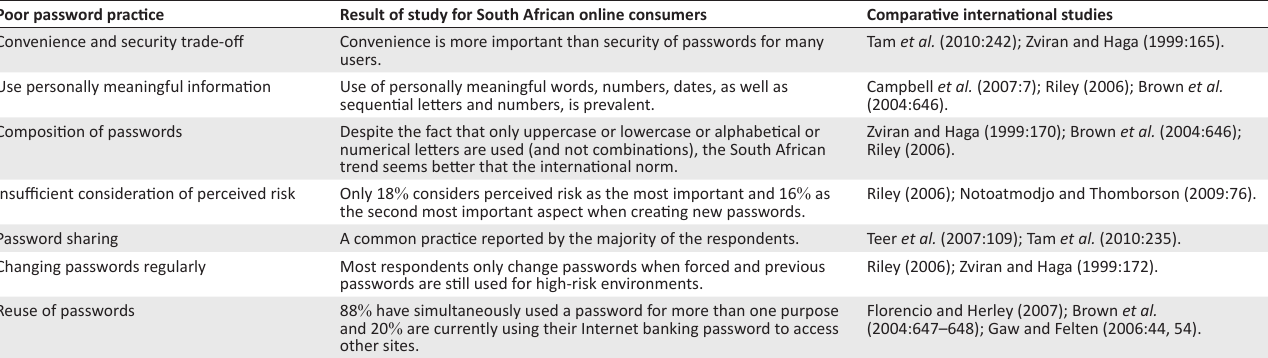
TABLE 1: Comparison of summary of poor password practices evident from this study with international studies. Poor password